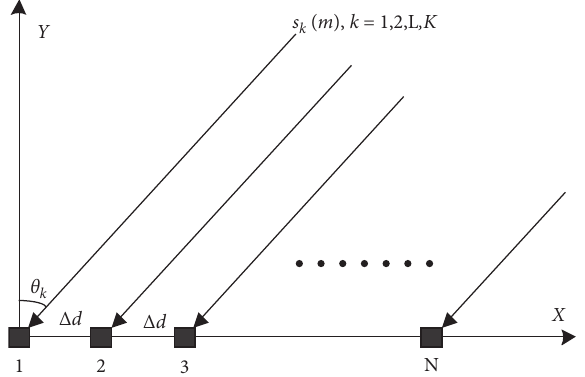
Figure 1: The configuration of a